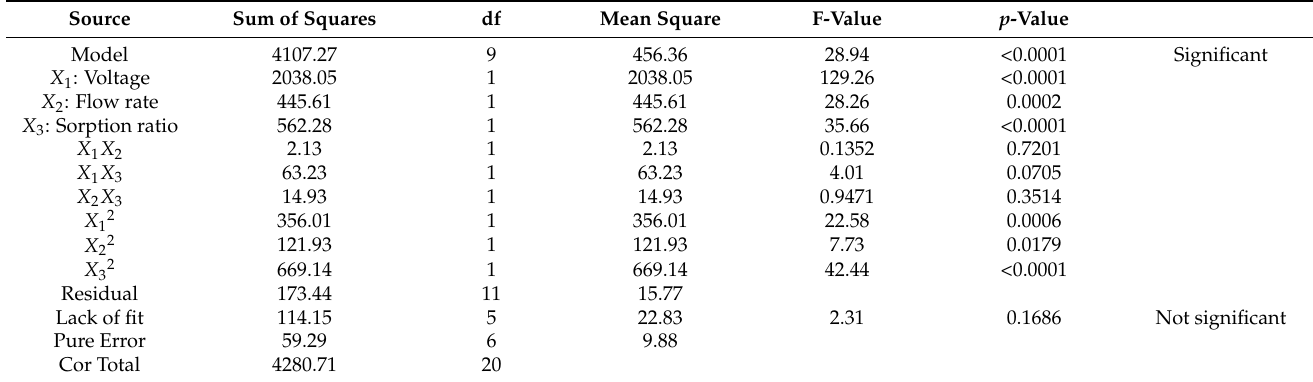
𝑌 2 : Water Production 𝑋 2 : Flow rate 𝑋 3 : Sorption ratio According to the results of ANOVA (analysis of variance) (Table 8), the F-value of the model was 248.67 ( p -value < 0.0001), which means that the model is significant. The corresponding coefficient of determination R 2 was 0.9907. Contrary to the case of TDS re- moval, the voltage was found to have no effect on water production. Figure 8 shows the response surface and contour plots for water production. An in- crease in flow rate resulted in an increase in water production, while an increase in sorp- tion ratio resulted in a slight decrease in water production. As mentioned earlier, the wa- ter production was constant regardless of the voltage. As can be seen in the figure, the water production is almost linearly proportional to the flow rate.